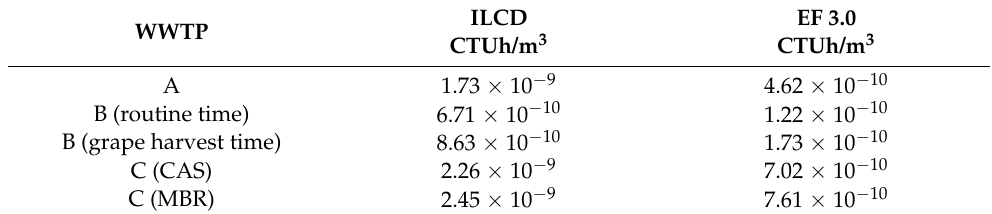
Table 4. Impact on human toxicity category: values of CTUh/m 3 for the studied WWTPs.